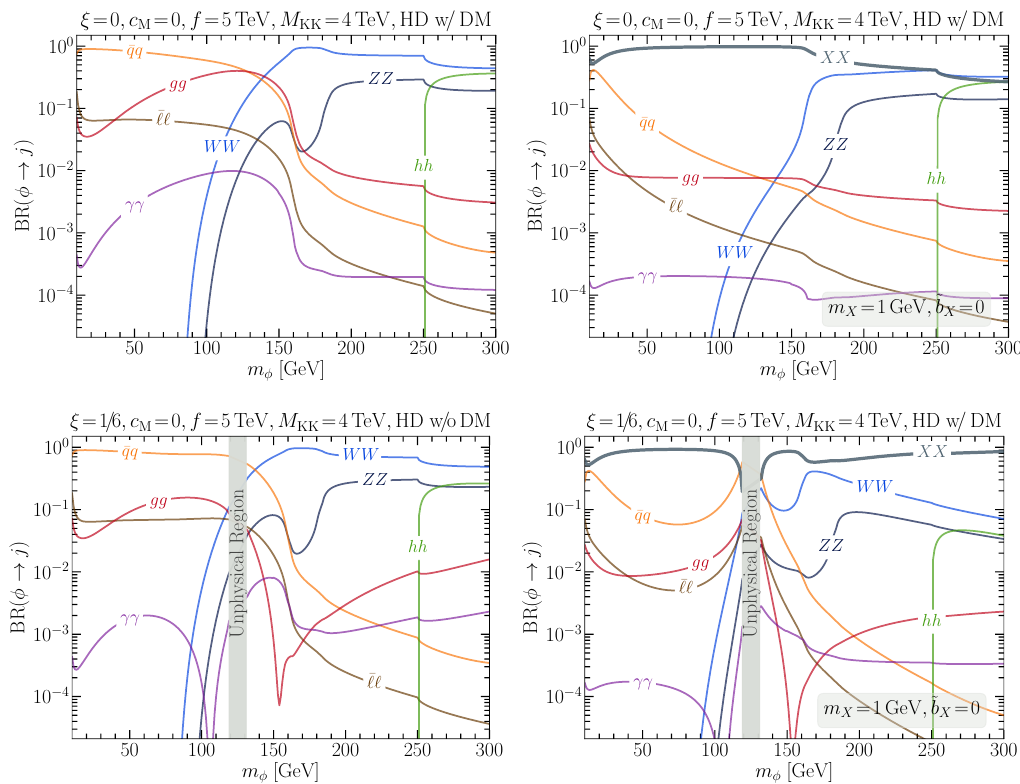
Figure 4 . Branching fractions of the dilaton in the holographic dilaton scenario as a function of the dilaton mass m (cid:30) . The upper (lower) panels are for (cid:24) = 0(1 = 6) without (left-panel) and with (right-panel) the presence of dark vector dark portal, respectively. The gray vertical band in the lower-panel plots corresponds to the unphysical region for the given